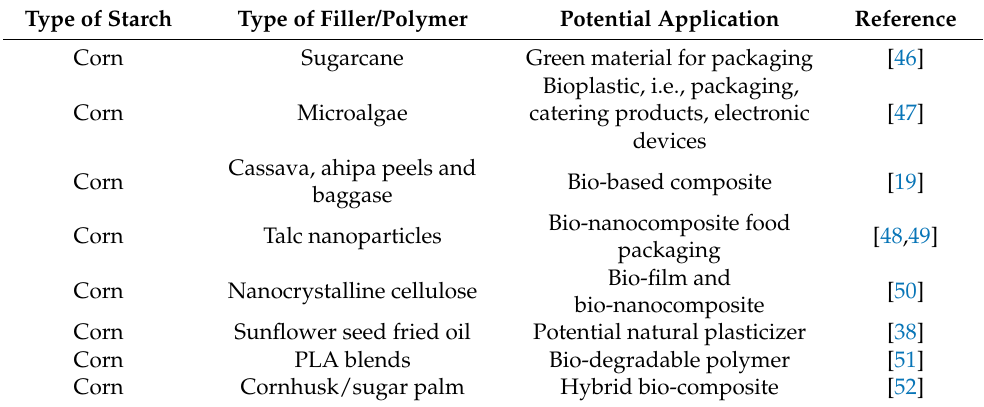
Table 2. Thermoplastic corn starch